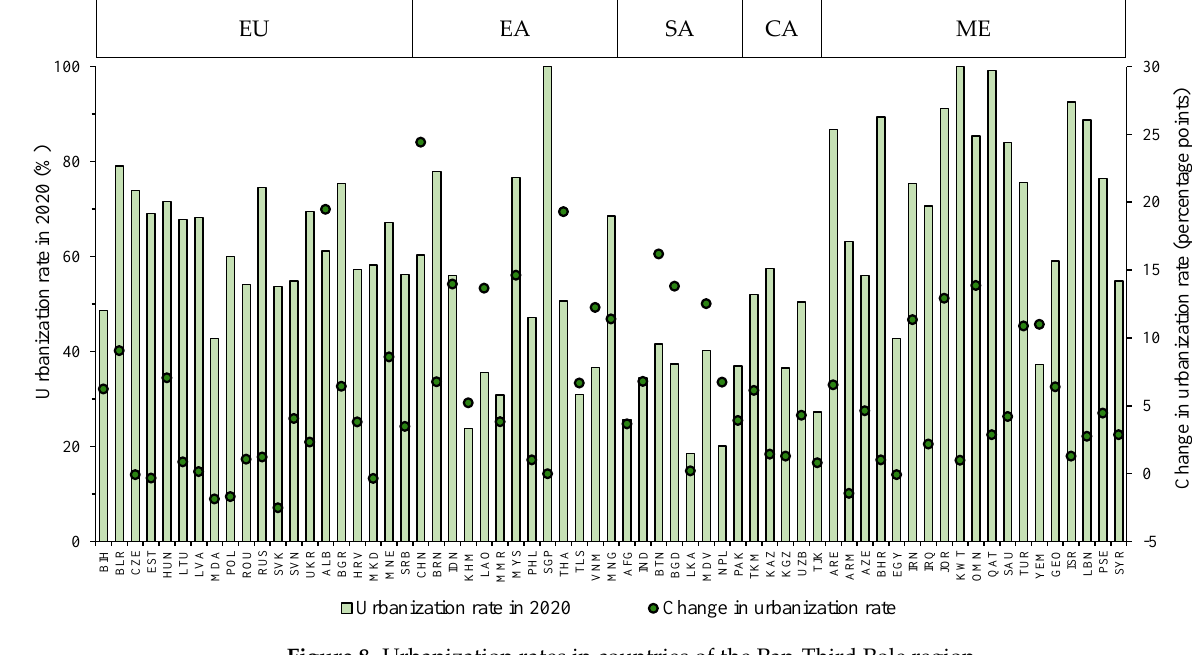
Figure 8. Urbanization rates in countries of the Pan-Third Pole region.